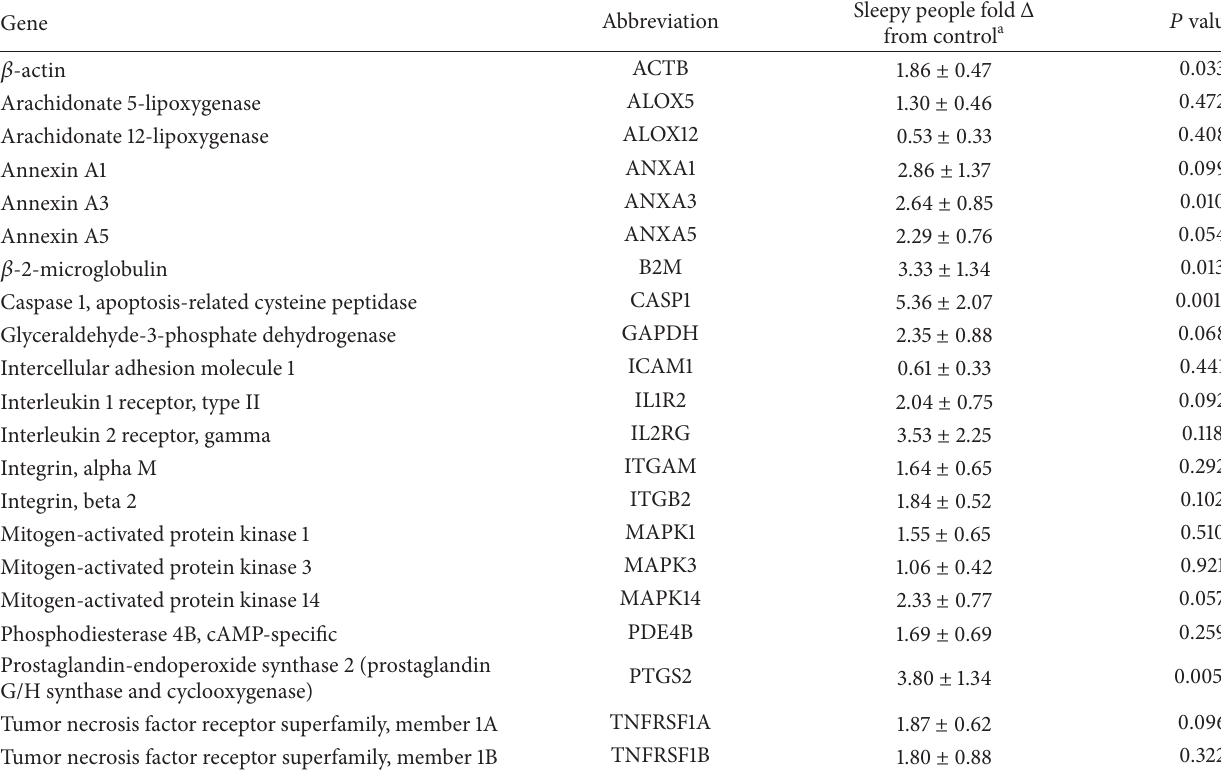
Table 4: Salivary transcript levels in “sleepy” patients compared to